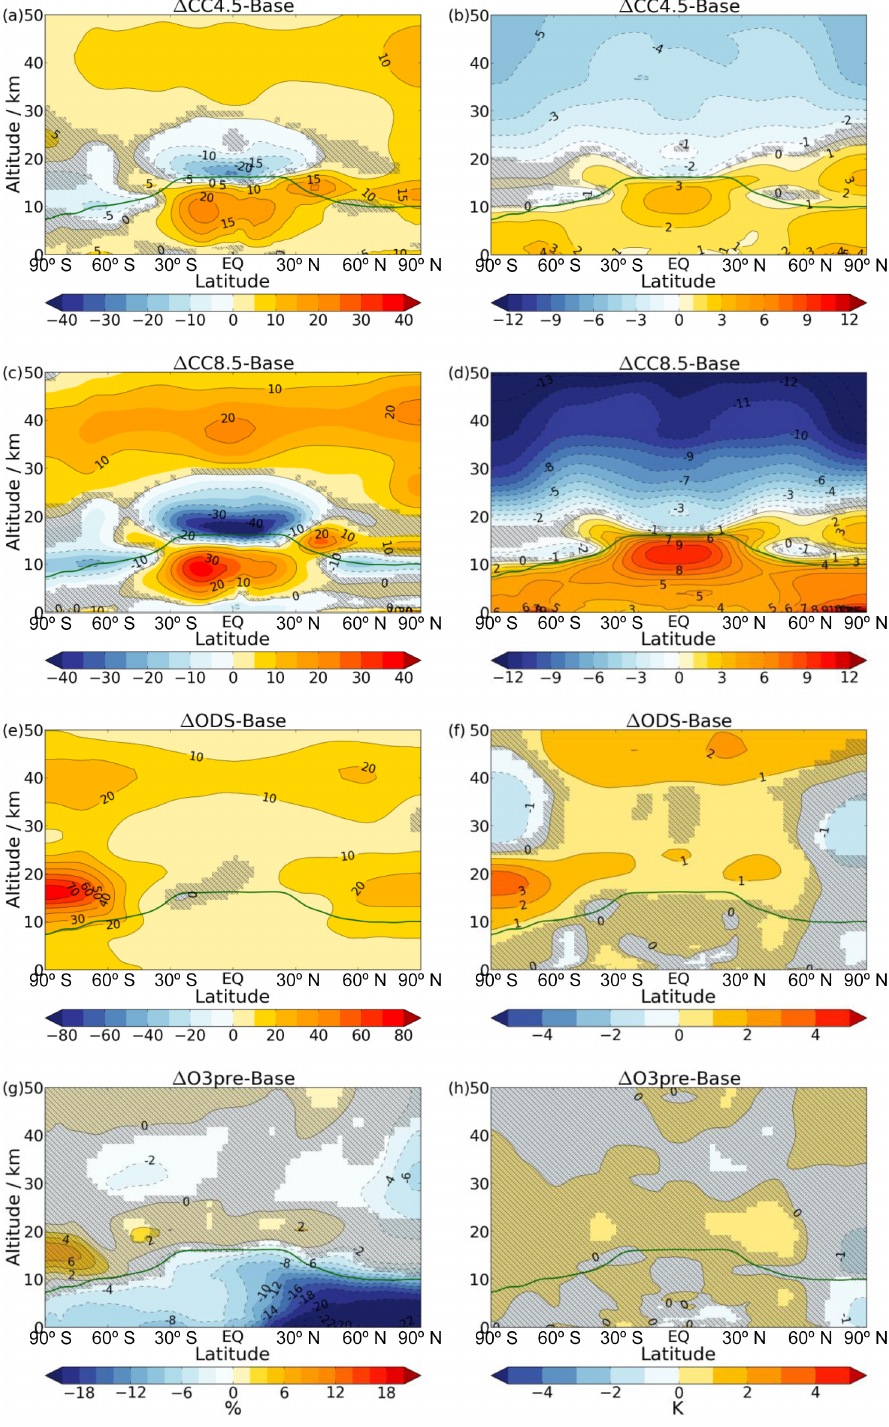
Figure 1. Changes in annual and zonal mean ozone (first column) and temperature (second column) for single-forcing experiments. Areas where the changes are not statistically significant at the 95% level according to a two-tailed Student’s t test are hatched out. The solid green line shows the thermal tropopause of the Base